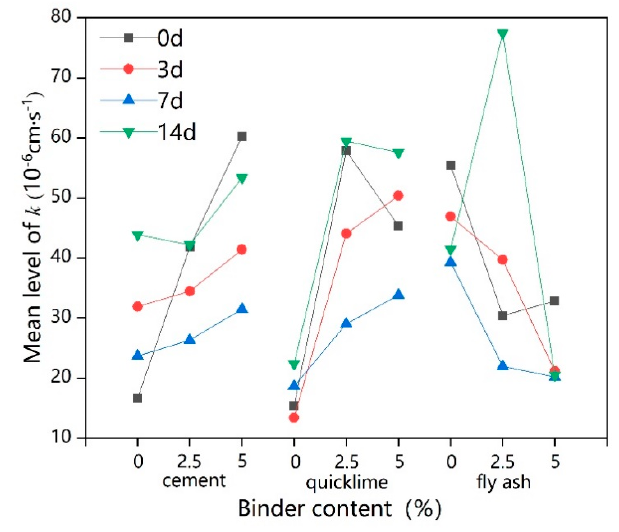
Figure 11. Intuitive trend chart of influencing factors for k .